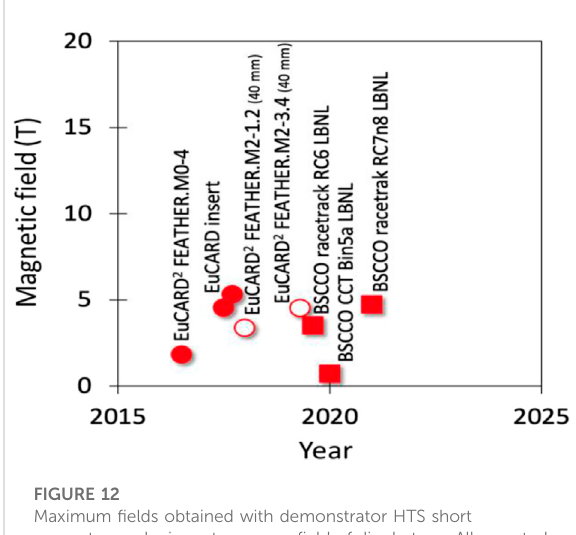
FIGURE 12 Maximum fi elds obtained with demonstrator HTS short magnets, producing a transverse fi eld of dipole type. All reported maximum value were reached in liquid helium (4.2 K). Solid symbols are coils with no bore (e.g., racetracks), while open symbols are real magnets, i.e., with a usable bore. Round symbols refer to coils built with REBCO, while square symbols refer to BSCCO-2212